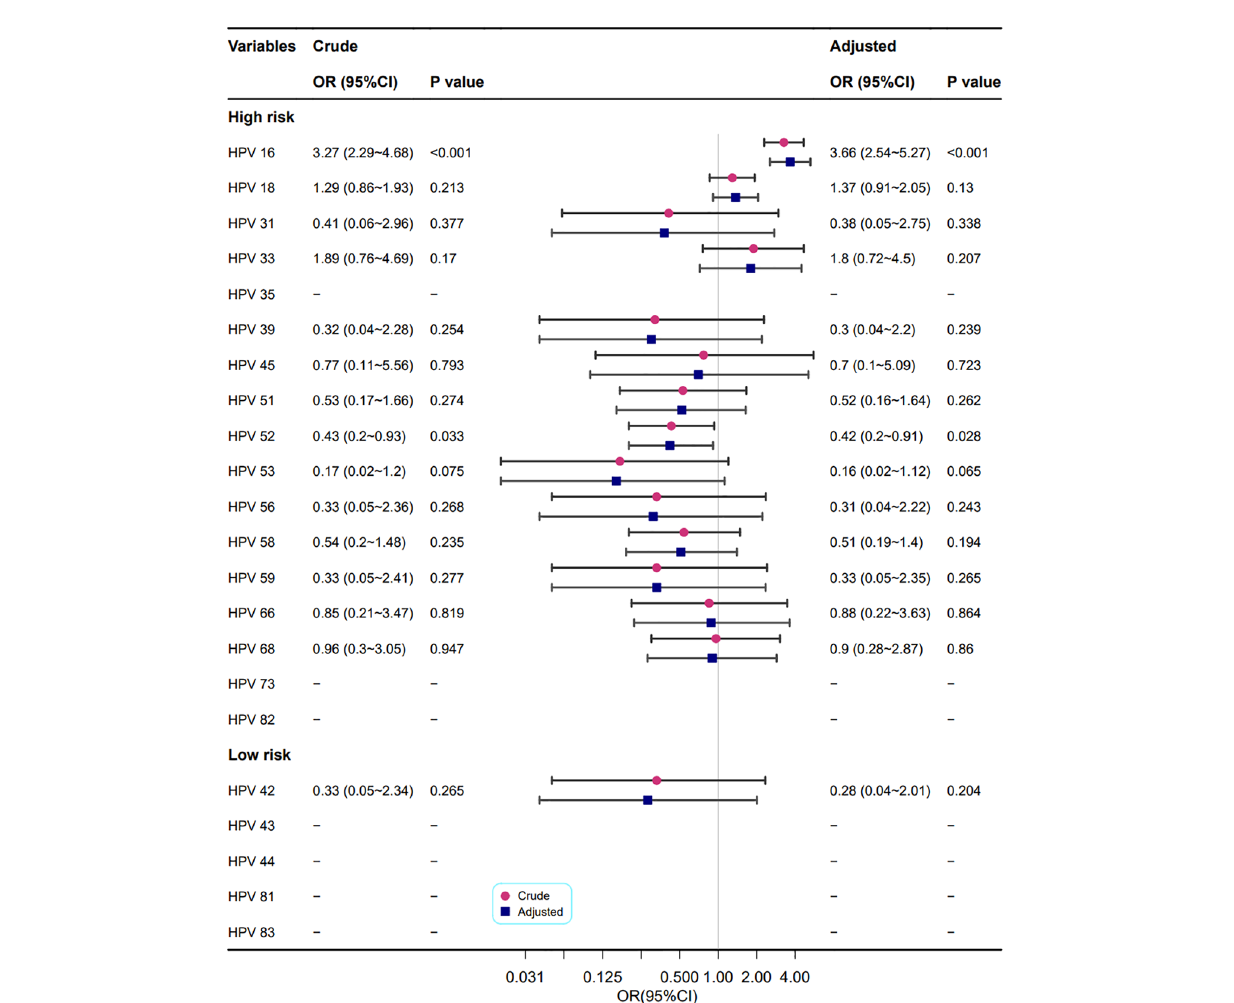
FIGURE 6 Association between different HPV types and cervical heteromorphic blood vessel features. Model adjustments for age, gravidity, and